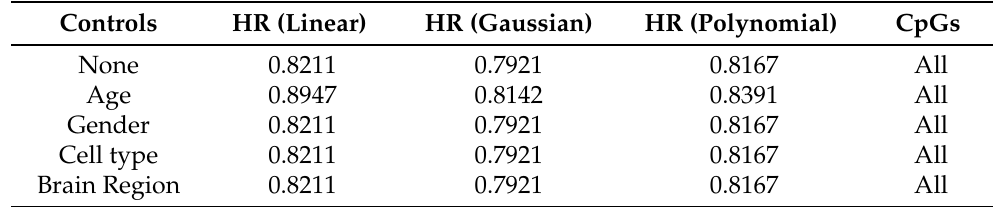
Table 6. Hit Rate (HR) of SVM with 3 different kernels for Alzheimer classification (versus control patients), using all the CpGs available (481,778) and controlling for different factors, such as age, gender, cell type, or brain region (GSE 66351 test